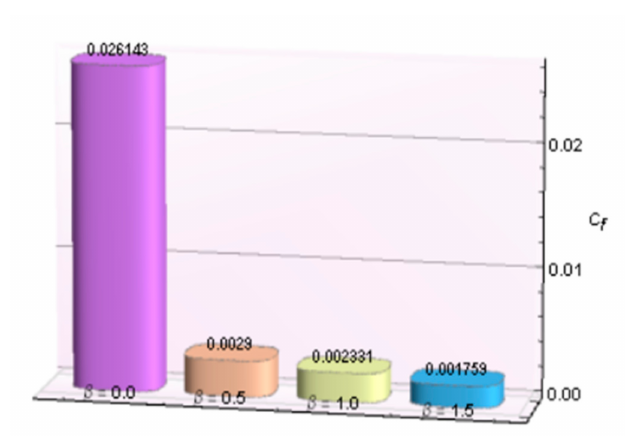
Figure 19. β verses C f .